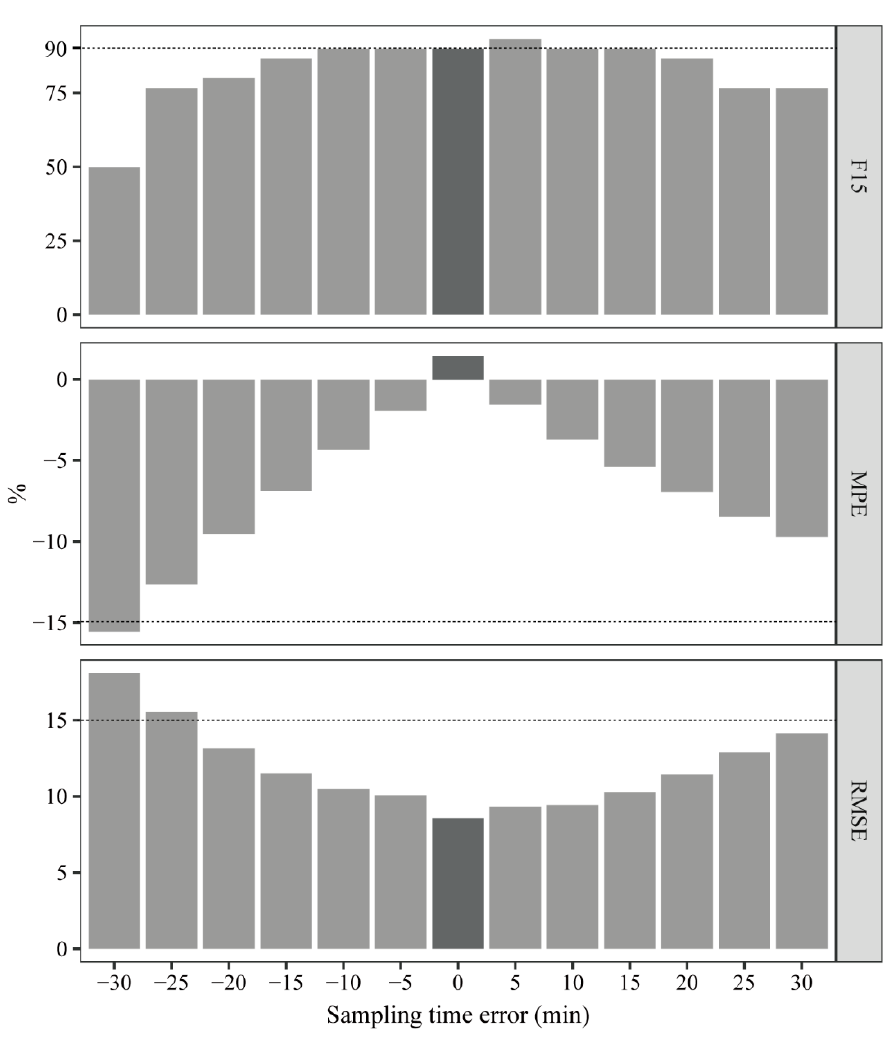
Figure 5. The MPE, RMSE, and F 15 of the AUC pred using LSS (C 0 , C 1 ) were developed by our center following the different sampling time errors (0, ± 5, ± 10, ± 15, ± 20, ± 25, and ± 30 min). Although the predictive performance of each model varied at different infusion times and sampling errors, feasible strategies were still identified if the acceptable RMSE was extended to ± 20%. The LSSs (C 4 , C 12 ) described by Chen et al. [21] and those by Wang et al. [22], (C 1 , C 4 , C 8 ) and (C 1 , C 1.5 , C 4 , C 8 ), presented overall acceptable predictability in terms of infusion time error (0.5 to 2.5 h). However, the LSSs (C 1 , C 4 , C 8 ) and (C 1 , C 1.5 , C 4